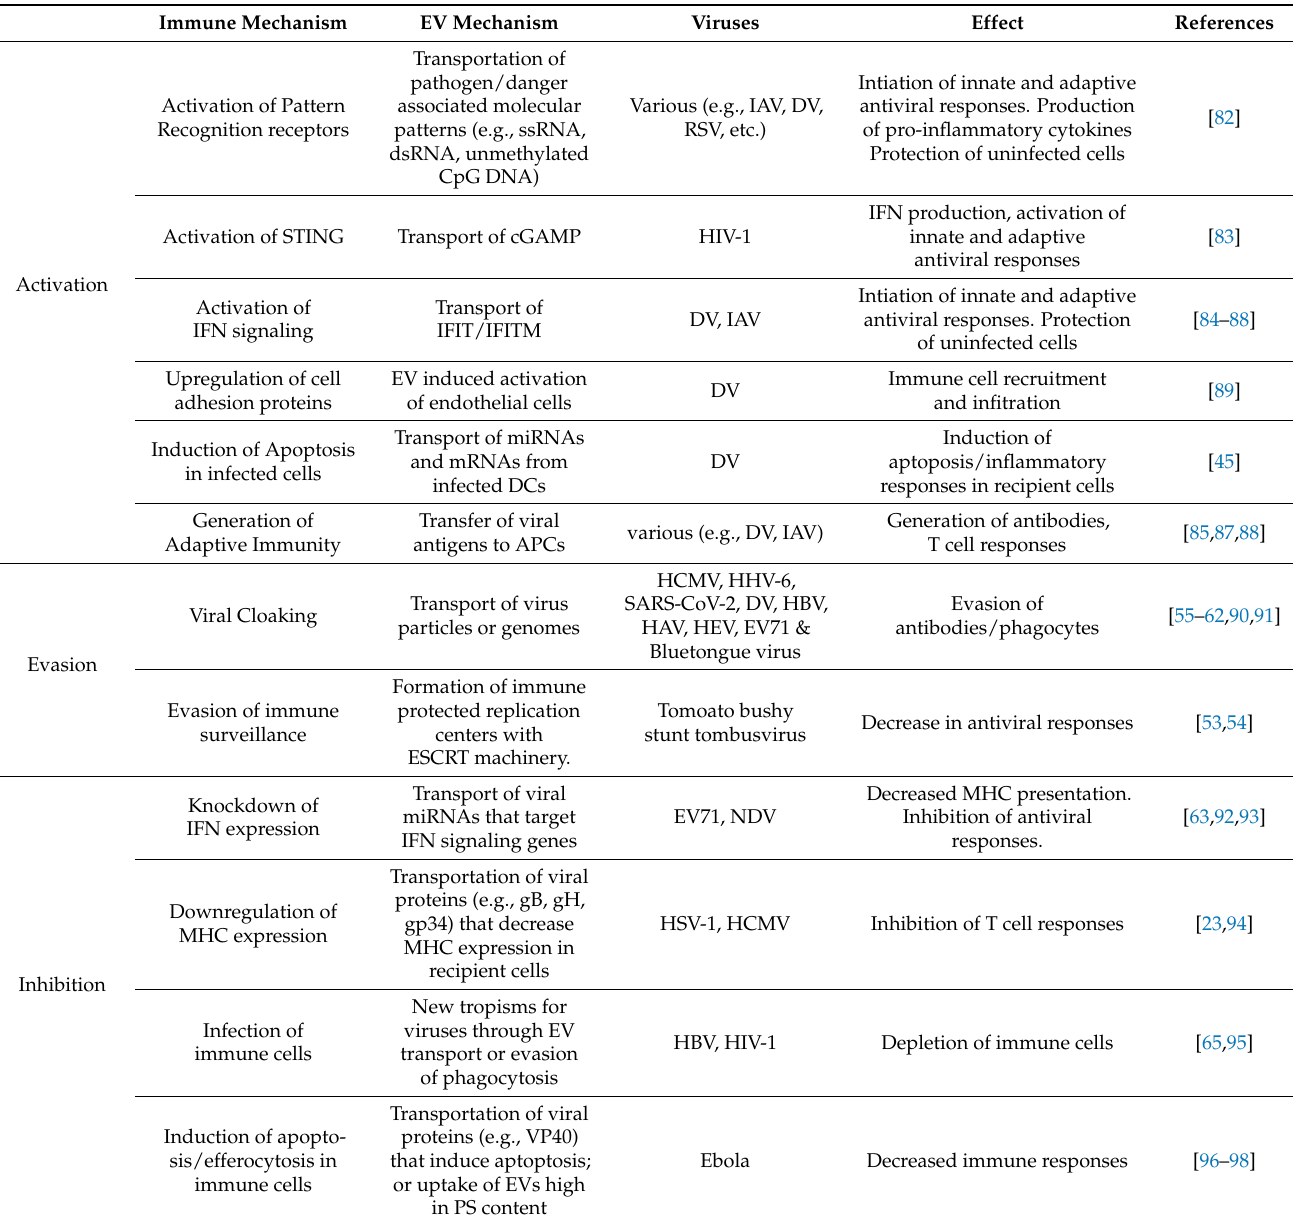
Table 1. Summary of immune system modulation by